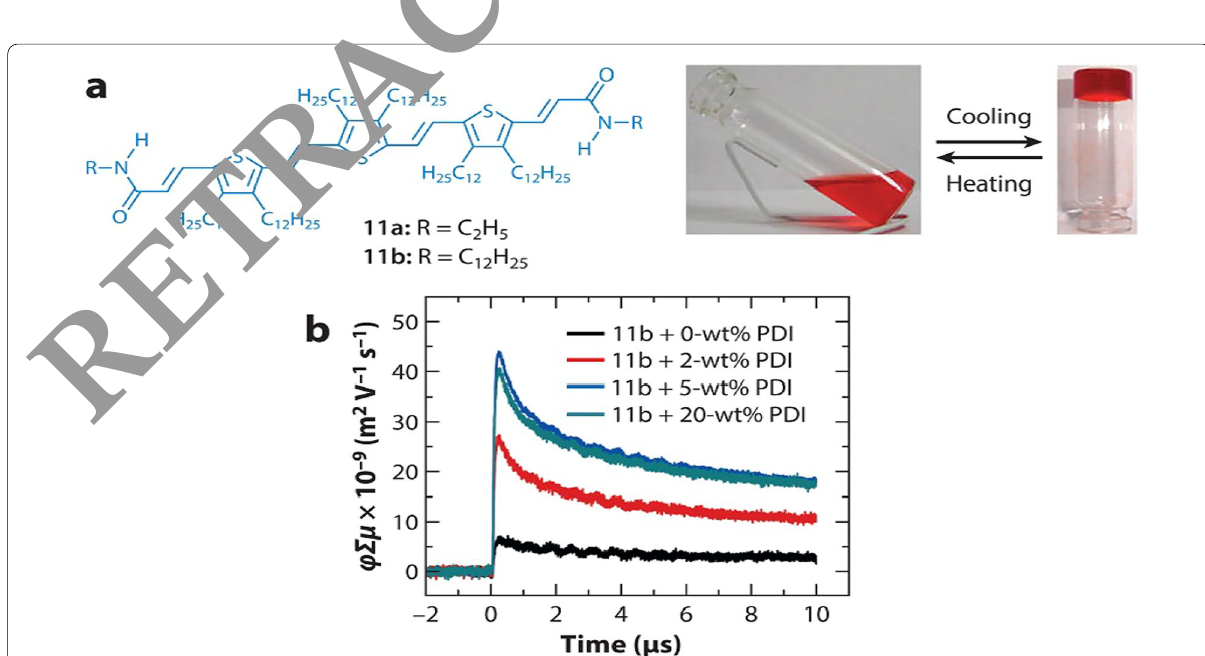
Fig. 6 a Molecular structures of thienylenevinylene-based gels (structures 11a and 11b) and optical images of structure 11b in solution (low temperature) and gel (high temperature); b a diagram of the electrical conductivity changes of structure 11b in exchange for the addition of different amounts of PDI duplex; c comparison of the mobility of thin films made of thienylenevinylene-based gels for the case where the film is produced from a solution or xerogel phase